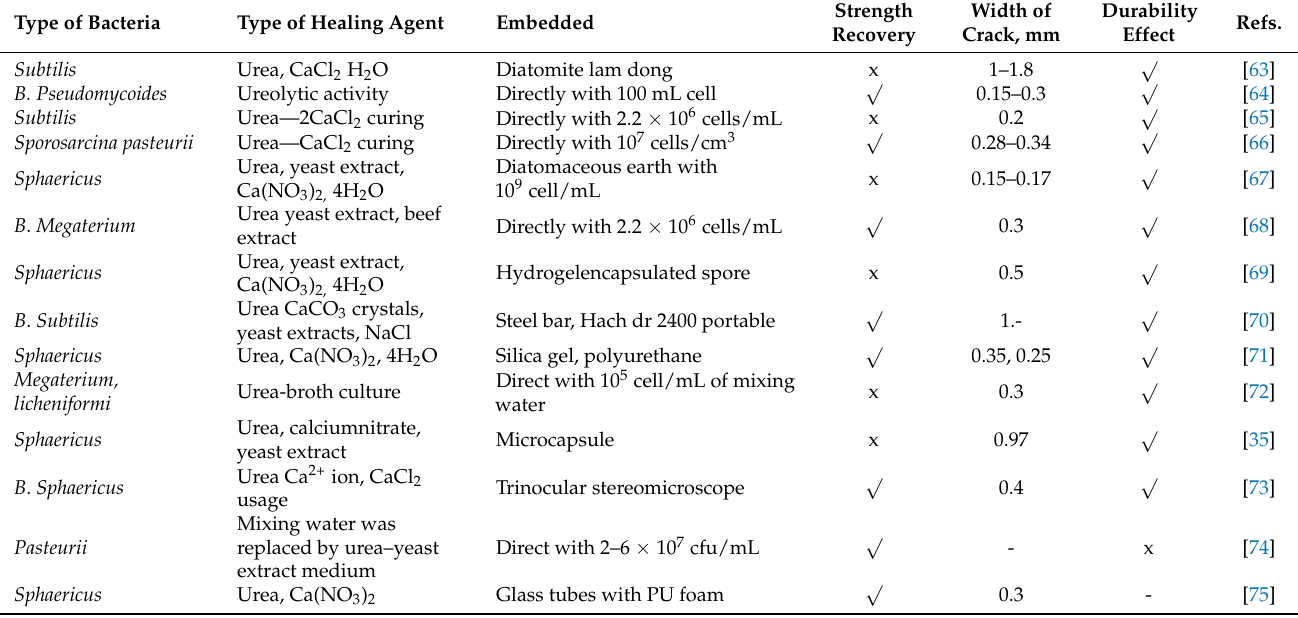
Table 1. The performance of bacteria species in healing